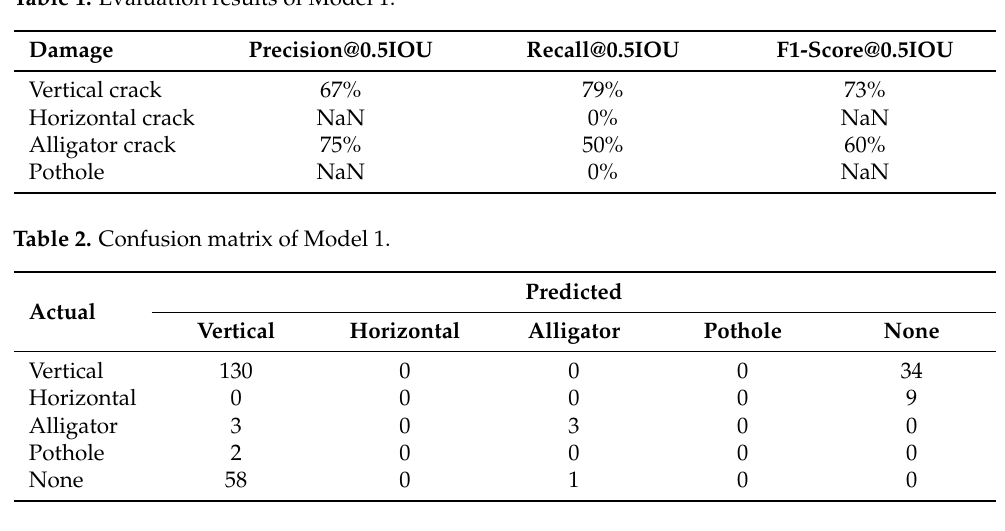
Table 1. Evaluation results of Model 1.